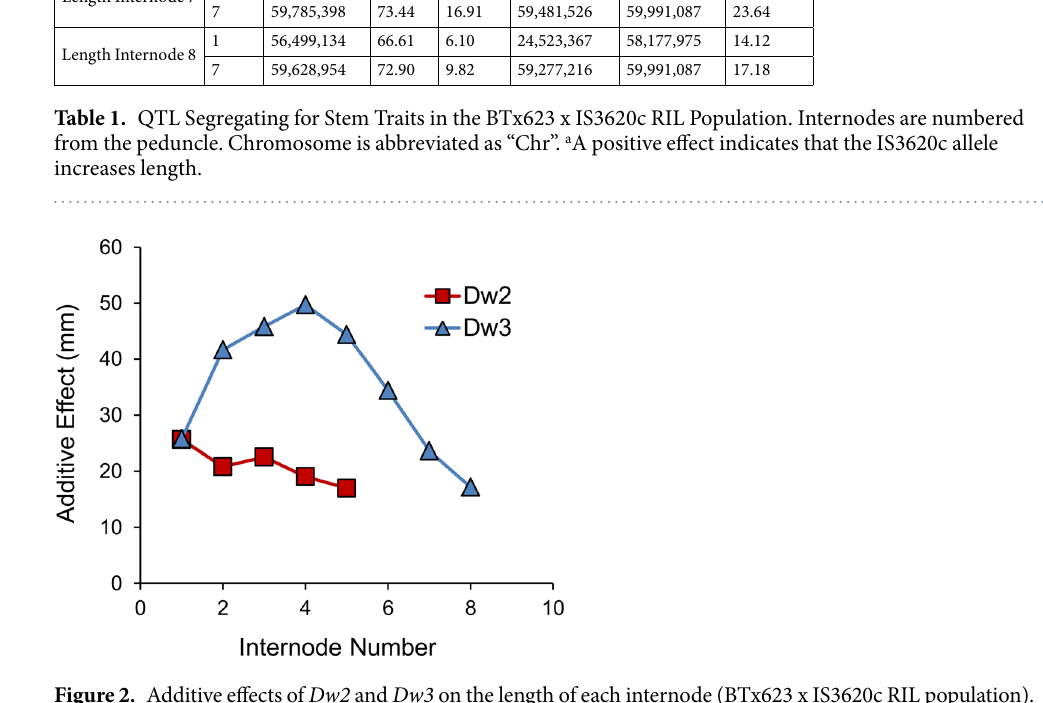
Figure 2. Additive effects of Dw2 and Dw3 on the length of each internode (BTx623 x IS3620c RIL population). The RIL population was grown in the greenhouse and the length of each internode (numbered from the peduncle) was measured. Additive effects were determined as part of QTL mapping performed in R/qtl using IM. The BTx623 allele of Dw2 increases internode length, whereas the IS3620c allele of Dw3 increases internode